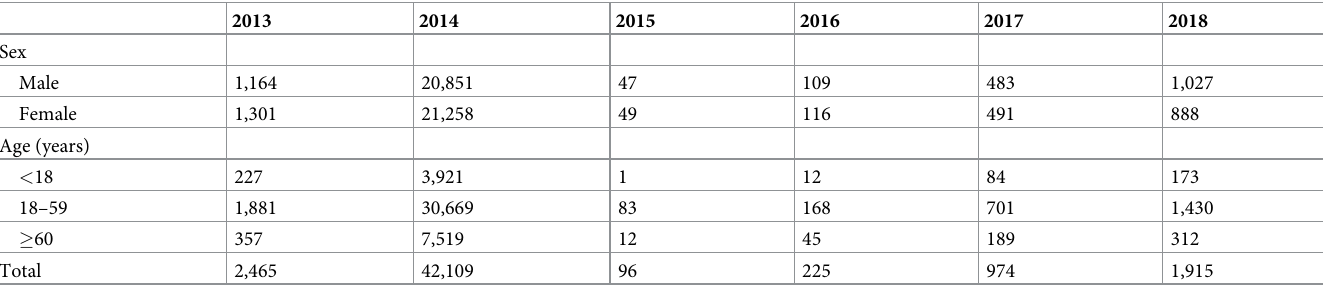
Table 2. The number of DF cases during study periods in the PRD from 2013 to